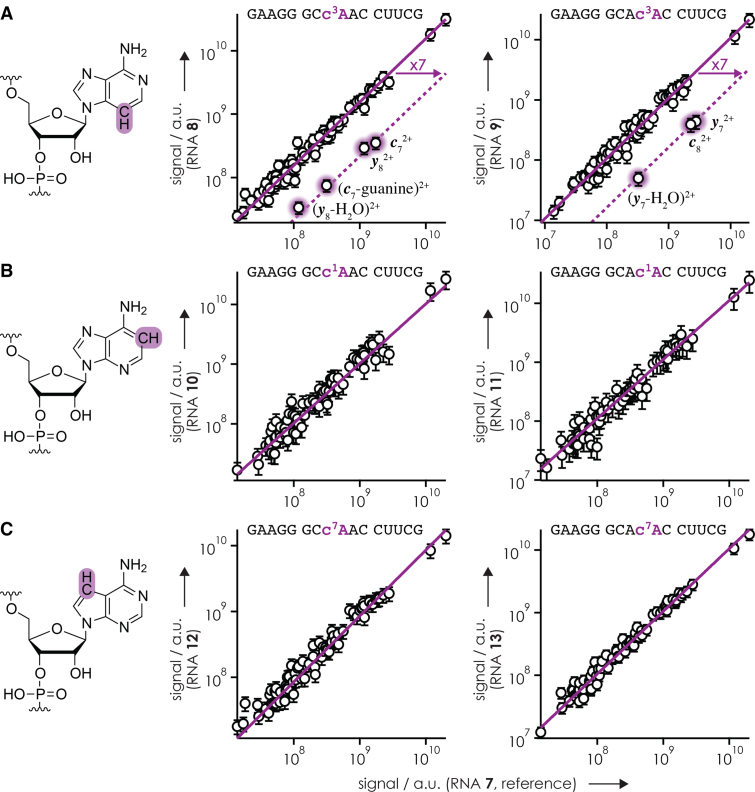
Signals of c and y fragments from CAD (42 eV laboratory frame collision energy) of (M+4H)4+ ions of (A) c3A-modified RNA 8 (position 8) and 9 (position 9), (B) c1A-modified RNA 10 (position 8) and 11 (position 9) and (C) c7A-modified RNA 12 (position 8) and 13 (position 9), versus those of the unmodified reference RNA 7 (CAA at positions 7–9).